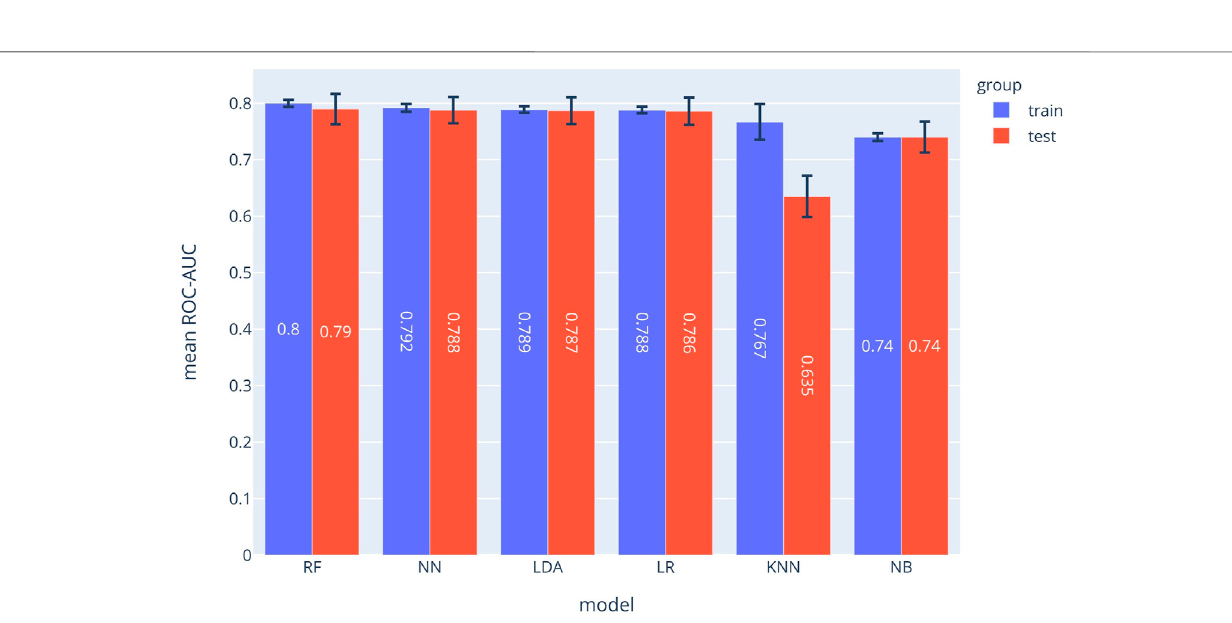
Frontiers in Arti fi cial Intelligence |